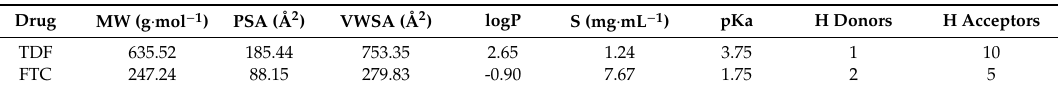
Figure 1. Three-dimensional (3D) chemical structures of tenofovir disoproxil fumarate (TDF) and emtricitabine (FTC). Chemical structures were generated with ‘Chemicalize’ tool from Chemaxon ® software. Table 2. In silico prediction of several physicochemical descriptors obtained from TDF and FTC chemical structure using Chemaxon ®